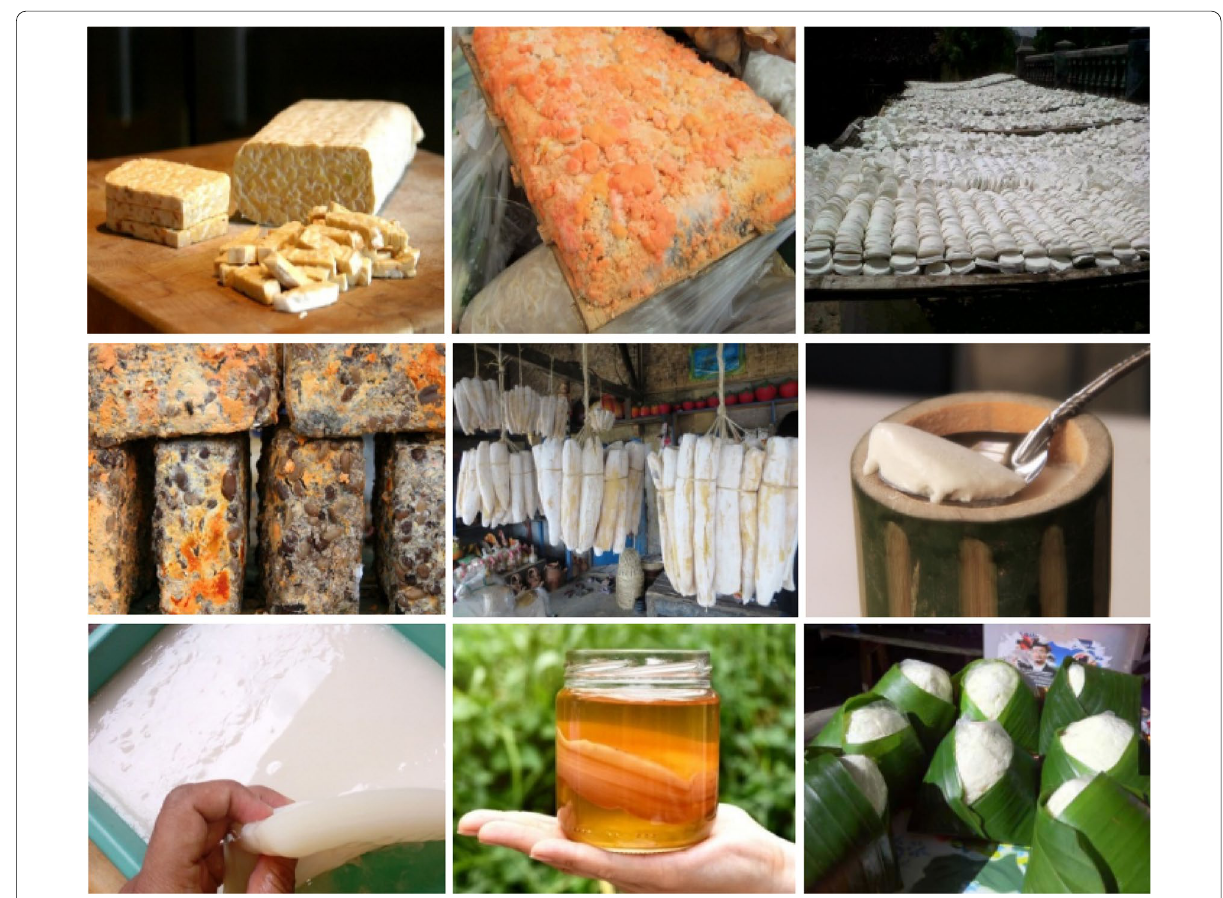
Fig. 6 Towards Unexplored Potency of Indonesian Biodegradable Material; Left to Right: Soybean cake, Red soy oil-cake, Solid fermented glutinous rice, Black soy oil-cake, Fermented cassava, Buffalo milk yogurt, Nata de coco, Kombucha, Enrekang cheese. Source: https:// www. indoi ndians. com/ ferme nted- foods- from- indon esia/. https://4. bp. blogs pot. com/- QEqST FN53Vo/ WlGzo lFTJkI/ AAAAA AAABKI/ K05Rd GnvBG knCZ8 gulJS ZjTYy 5jhAn cCQCL cBGAs/ s1600/ IMG_ 20170 721_ 143344. jpg. https:// stora ge. trubus. id/ stora ge/ app/ public/ posts/ t2019 0925/ big_ 39475 91202 3d773 c4b21 0e206 2cd32 a5fe9 04bd0. jpg downloaded on March 28,